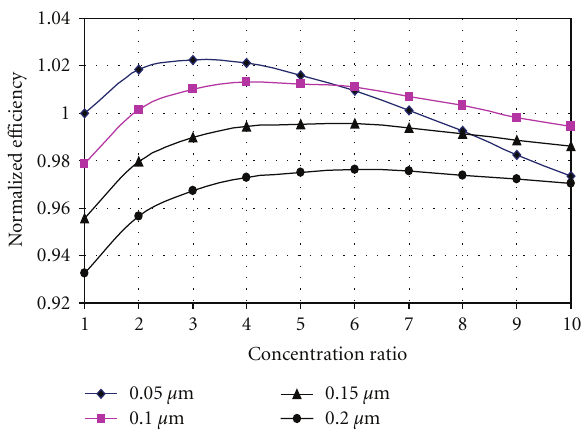
Figure 8: Normalized e ffi ciency variation with concentration ratio for di ff erent junction depth on grid-optimized and electroplated solar cells.